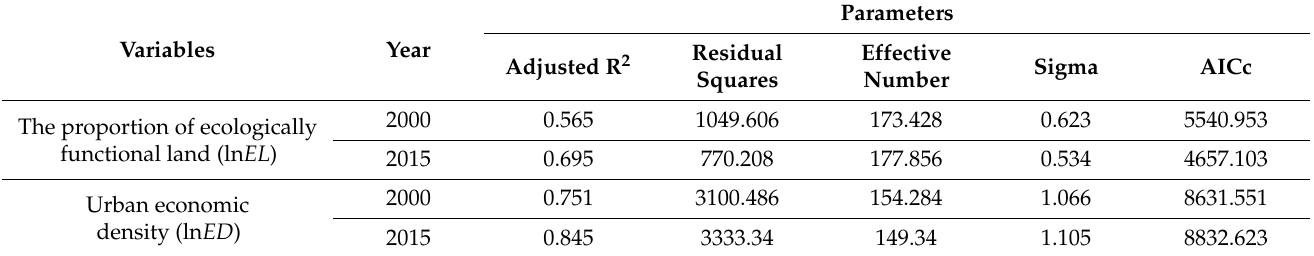
Table 5. Estimation parameters of GWR models.